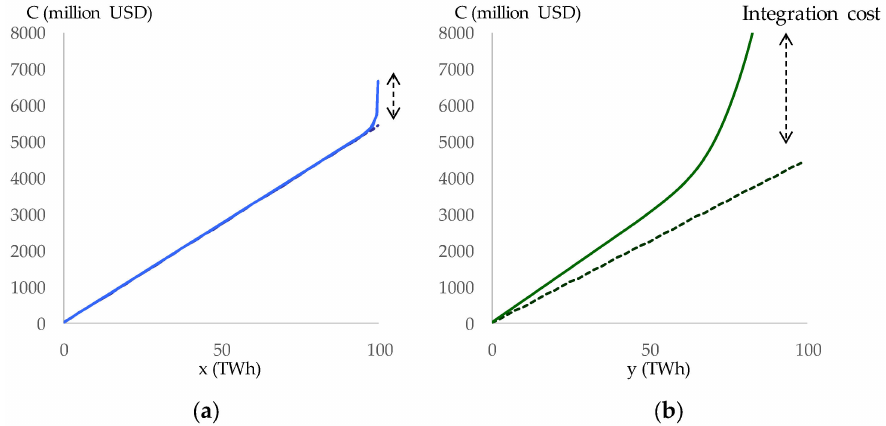
Figure A6. Total cost C and the integration cost I on subspaces y = 0 and x = 0. ( a ) y = 0; ( b ) x =